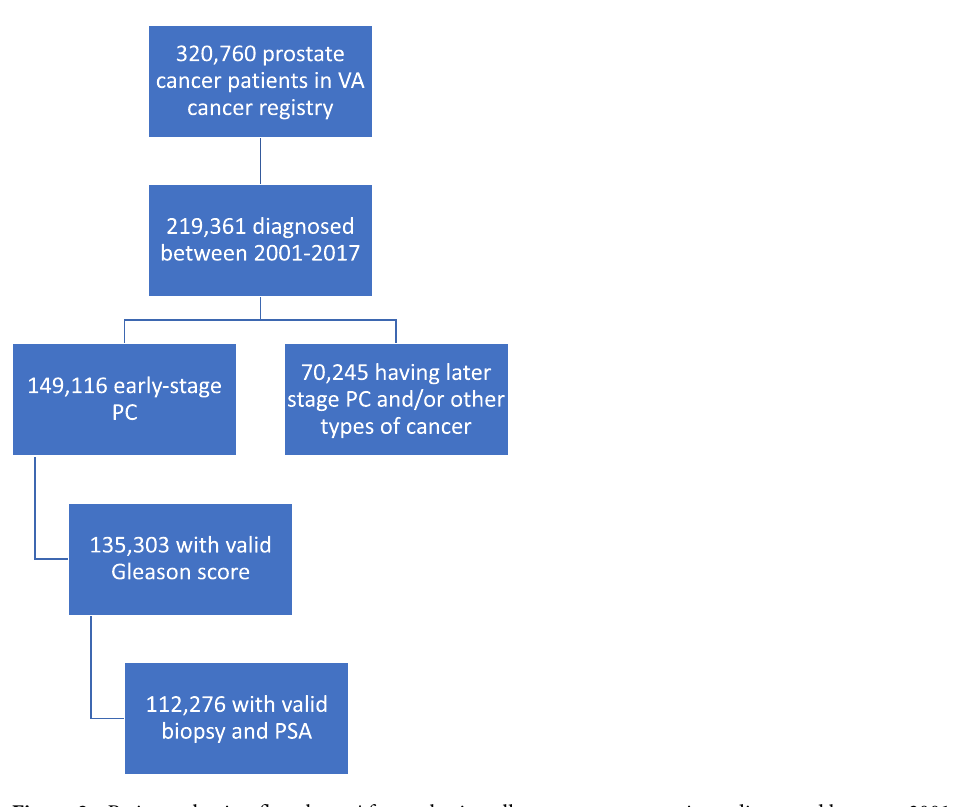
Figure 2. Patient selection flowchart. After gathering all prostate cancer patients diagnosed between 2001- 2017 in the VA cancer registry, we have excluded patients satisfying any of the following criteria: (1) late-stage (metastasized) prostate cancer or having other types of cancer at the time of diagnosis, (2) no valid PSA test 1 year before diagnosis, (3) no valid Gleason score (Unknown or < 6 ), and (4) no biopsy record for